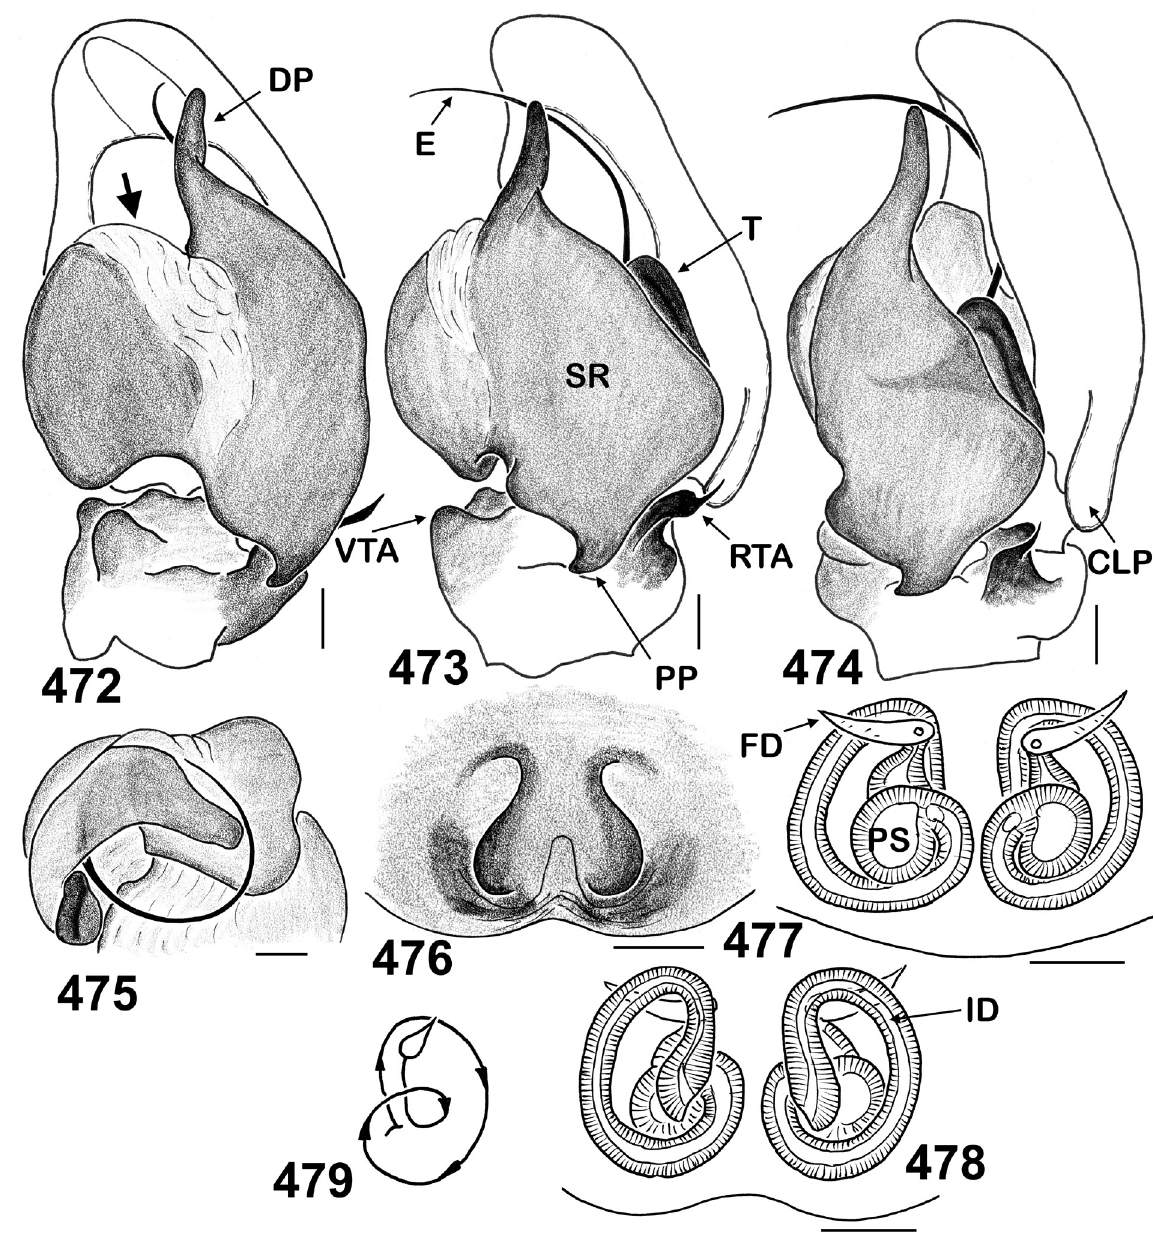
Figs 472–479. Stenaelurillus termitophagus (Wesołowska & Cumming, 1999) comb. nov., ♂ from Botswana, (Mopane Woodland) and ♀ from Botswana (island in Moanachira River) . 472–474 . Male palp. 472 . Ventral view. 473 . Ventro-retrolateral view. 474 . Retrolateral view. 475 . Embolic division, apical view. 476 . Epigyne, ventral view. 477 . Spermathecae, dorsal view. 478 . Spermathecae, ventral view. 479 . Diagrammatic course of the insemination ducts. Abbreviations: see Material and methods. Scale bars: 0.1